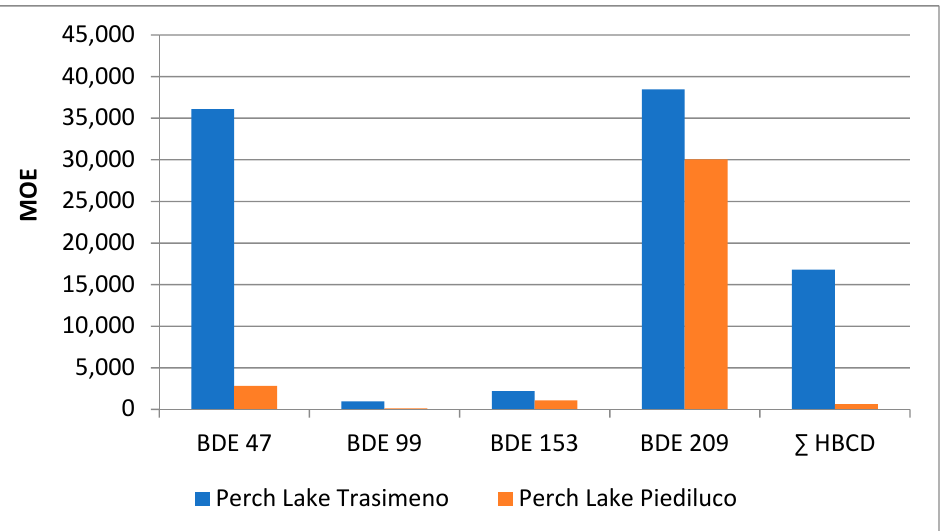
Figure 3. Comparison between MOE values related to perch samples from Lakes Trasimeno and Piediluco.